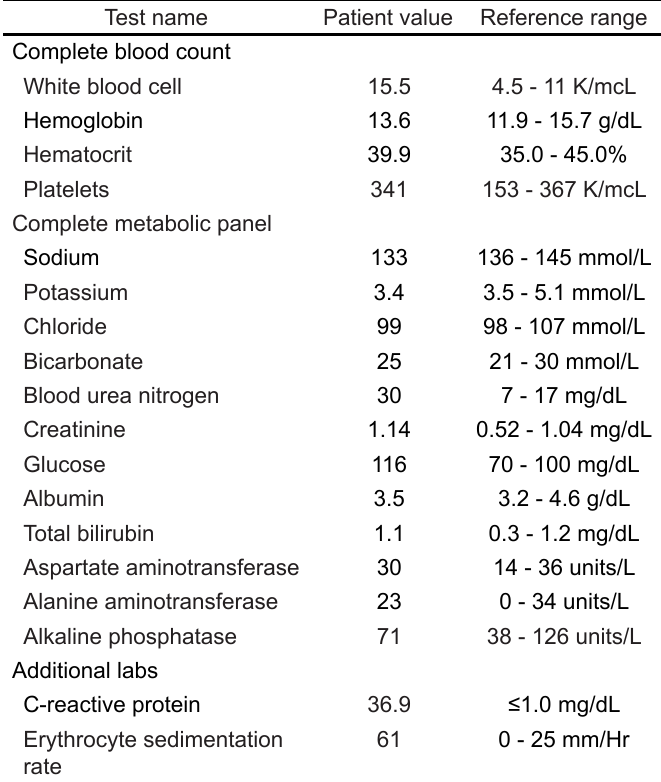
Table 1 . Laboratory values of a 45 year-old male with bilateral lower extremity wounds, swelling and